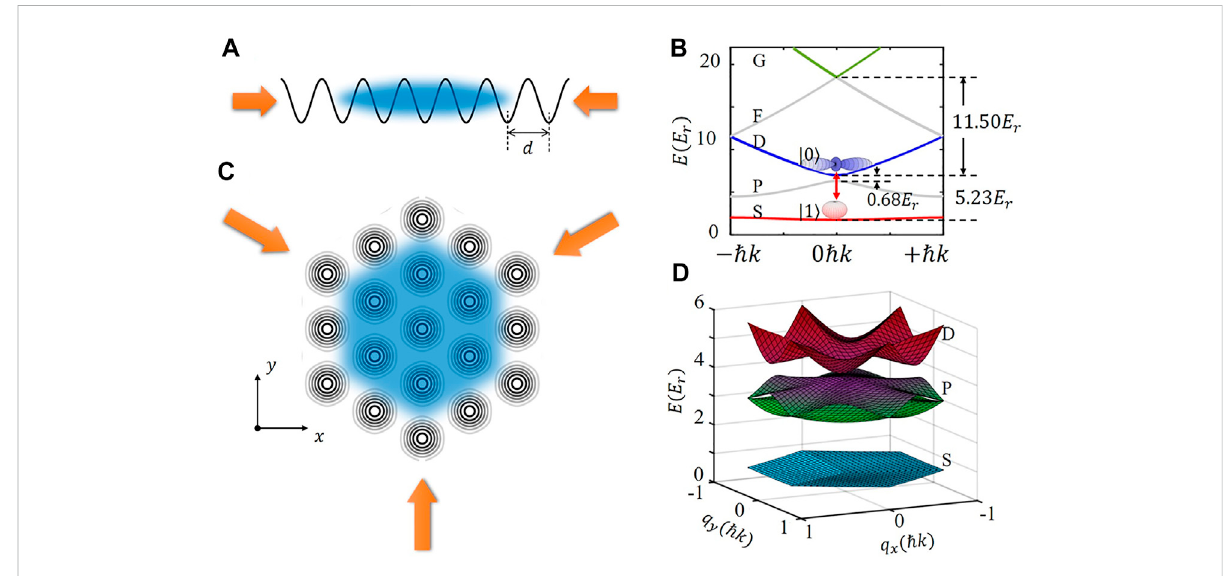
FIGURE 1 Schematicdiagram and band structure ofoptical lattices. (A) isa 1D optical lattice with the lattice constant d . (B) The band-gap structures of1D opticallatticeforlatticedepth V =5 E r withlaserwavelength1,064 nm. (C) isatriangularopticallattice,withthecorrespondingbandstructure (D) for lattice depth V = 3 E r .